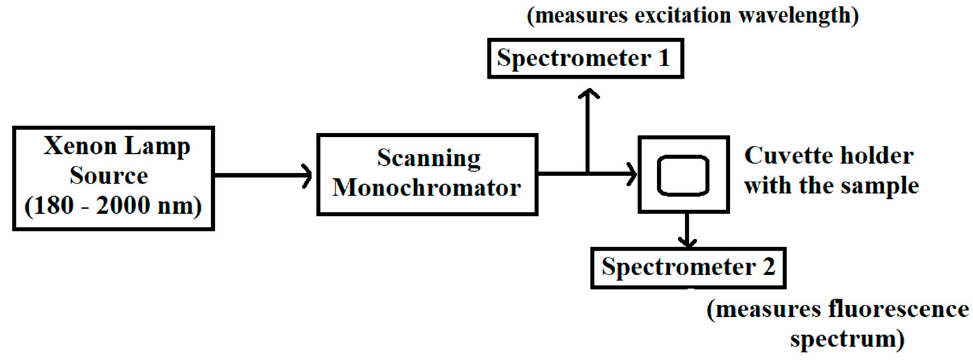
Figure 3. Ocean Optics fluorescence spectroscopy set-up at EARTH lab. The arrow represents the direction of the light.